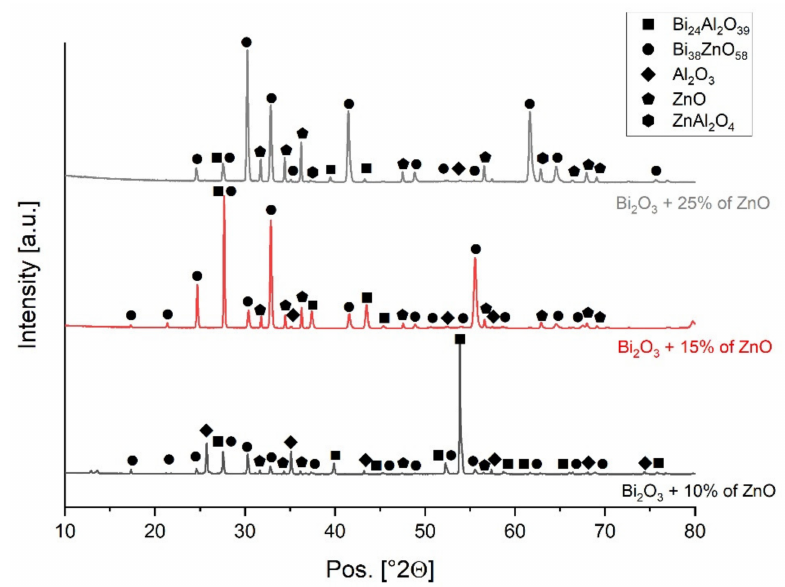
Figure 7. XRD spectra of alumina coated with mixtures of Bi 2 O 3 and ZnO and fired at 750 ◦ C.